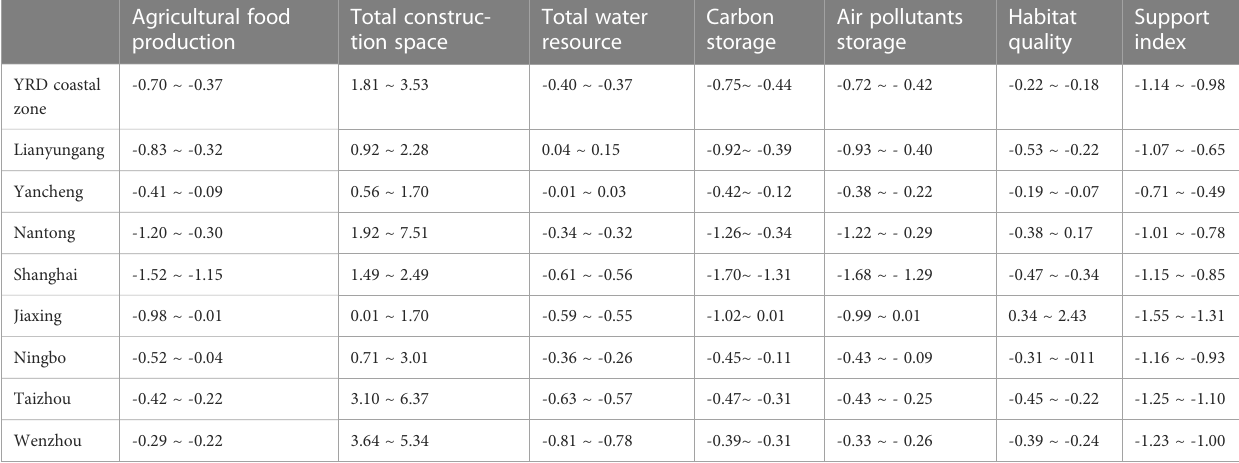
TABLE 6 Support index change in 2020-2050 (%/a).